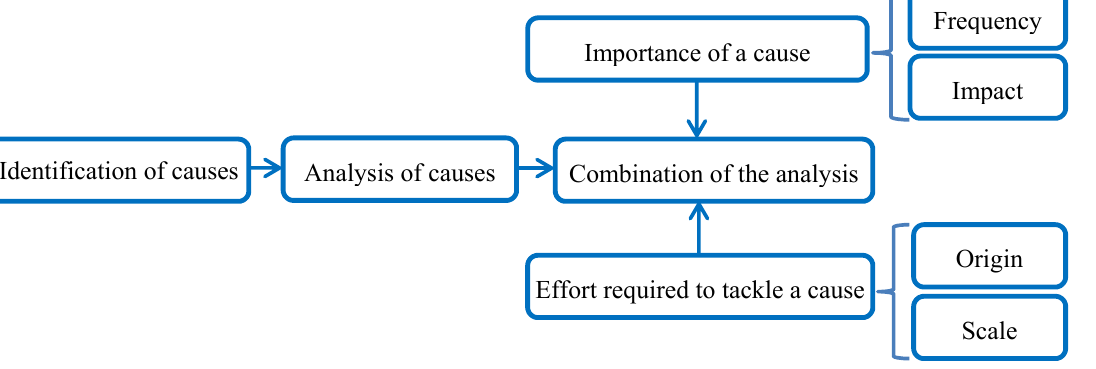
Figure 1. The research process and indicators.